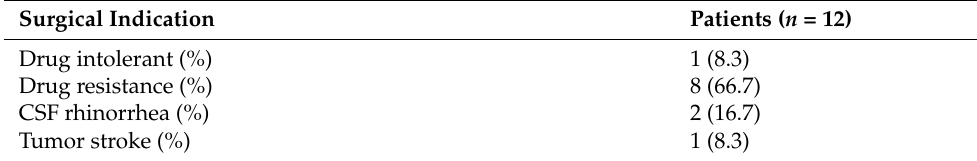
Table 5. Surgical indications for 12 patients regularly treated with bromocriptine. Surgical Indication Patients ( n =